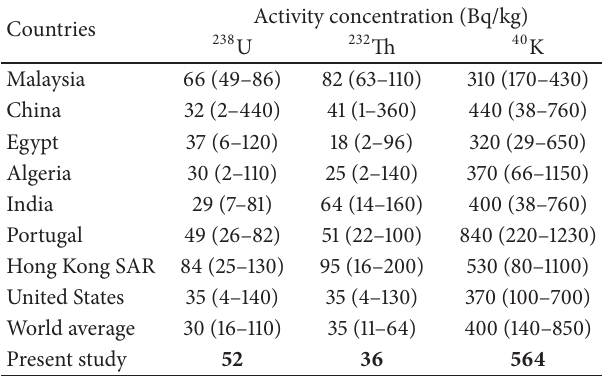
Table 3: Comparison of natural radioactivity levels in the soil of Likuyu village with those in other countries as given in UNSCEAR (2000) [11].